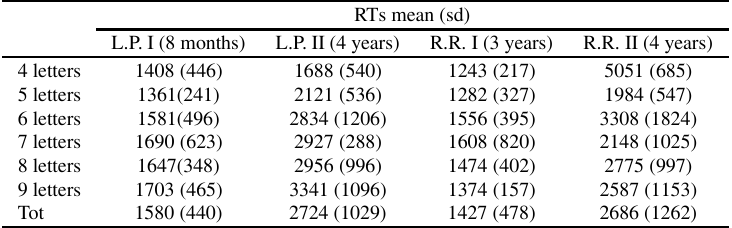
Table 4 Reaction times (RTs) mean for L.P. and R.R. for both periods and for each condition